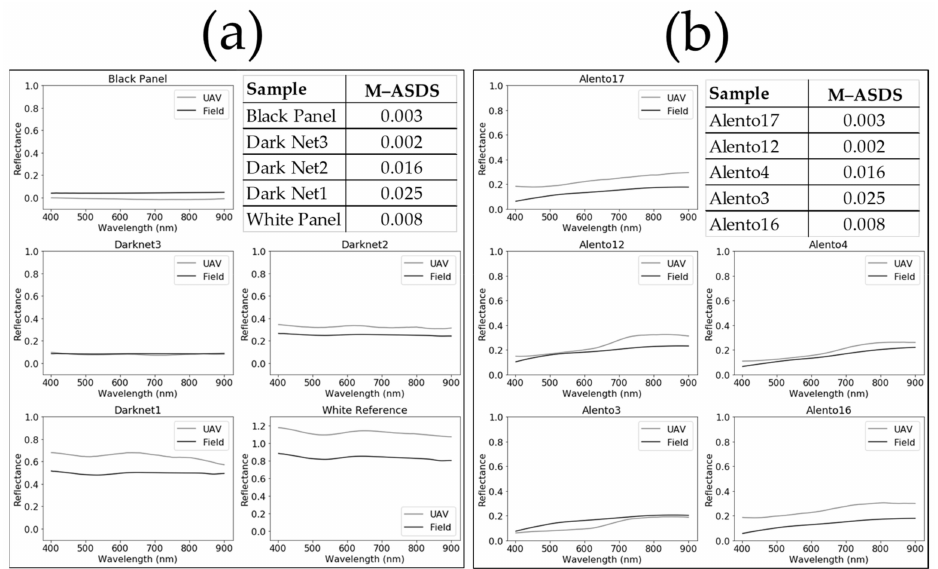
Figure 14. Field samples for validation. Gray line, UAV spectrum; black line, field spectrum. ( a ) Validation panels. ( b ) Validation soil